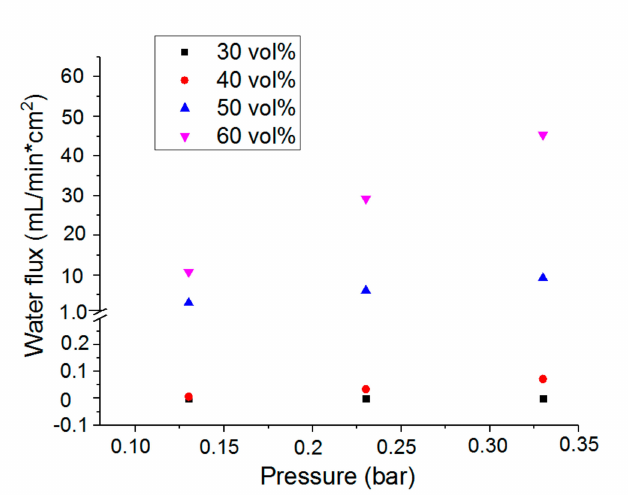
Figure 5. Water flux through the microporous PTMC films, vol % refers to the amount of CaCO 3 particles used during preparation of the films.